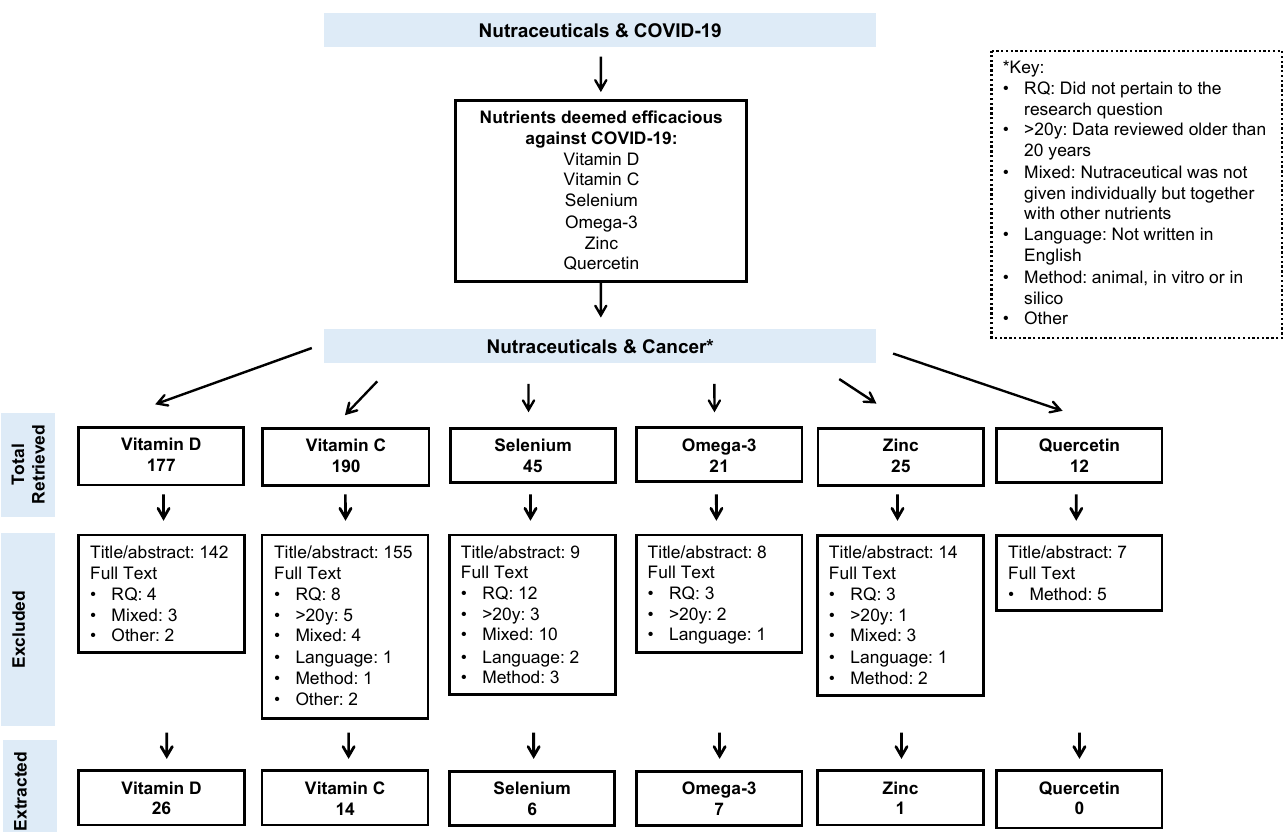
Figure 1. Search methodology and article selection process.